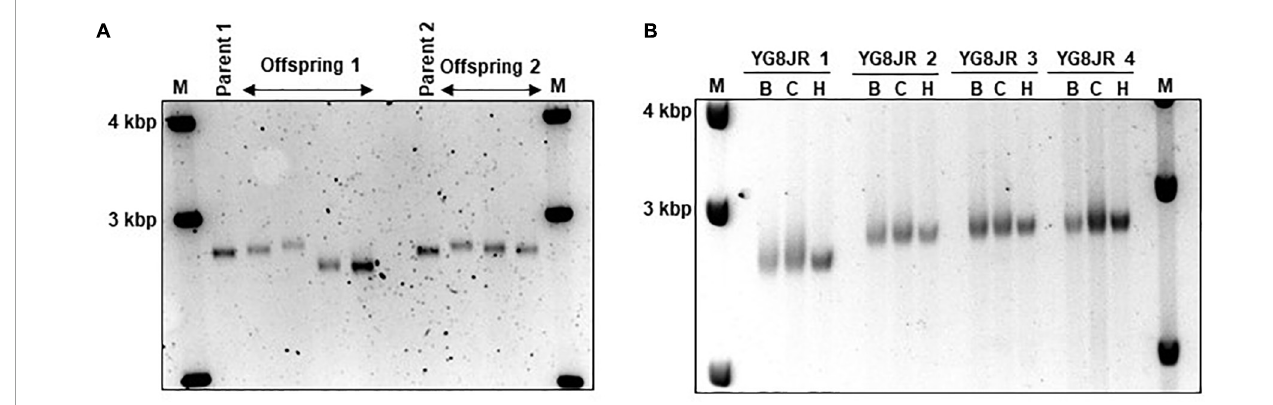
FIGURE2 Intergenerational and somatic guanine-adenine-adenine (GAA) repeat analysis. (A) Representative example of GelRed stained 1.5% agarose gel determines the GAA PCR sizes of skeletal muscle tissues from parents and offspring YG8JR FRDA mice indicating a range from approximately 820 to 900 GAA repeat units in size within FXN gene. Parent 1: male, 7 months old. Parent 2: female, 6 months old. Offspring 1: males, 8–9 months old. Offspring 2: females, 6–9 months old. (B) DNA samples from different tissues of YG8JR FRDA mice. YG8JR 1: female, 9 months old. YG8JR 2: male, 9 months old. YG8JR 3: male, 8 months old. YG8JR 4: male, 9 months old. B, brain; C, cerebellum; H, heart. 1 Kb plus DNA ladder was used as the molecular marker (M).